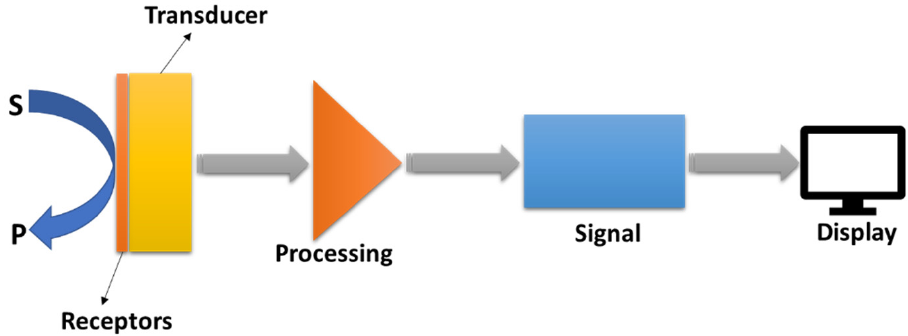
Figure 1. A schematic diagram illustrating the major components of a standard sensor. Adapted with permission from Shetti, N.P.; Nayak, D.S.; Reddy, K.R.; Aminabhvi, T.M. Graphene–Clay-Based Hybrid Nanostructures for Electrochemical Sensors and Biosensors. In Graphene-Based Elec- trochemical Sensors for Biomolecules; Elsevier, 2019; pp. 235–274, ISBN 9780128153949, Reference [3].